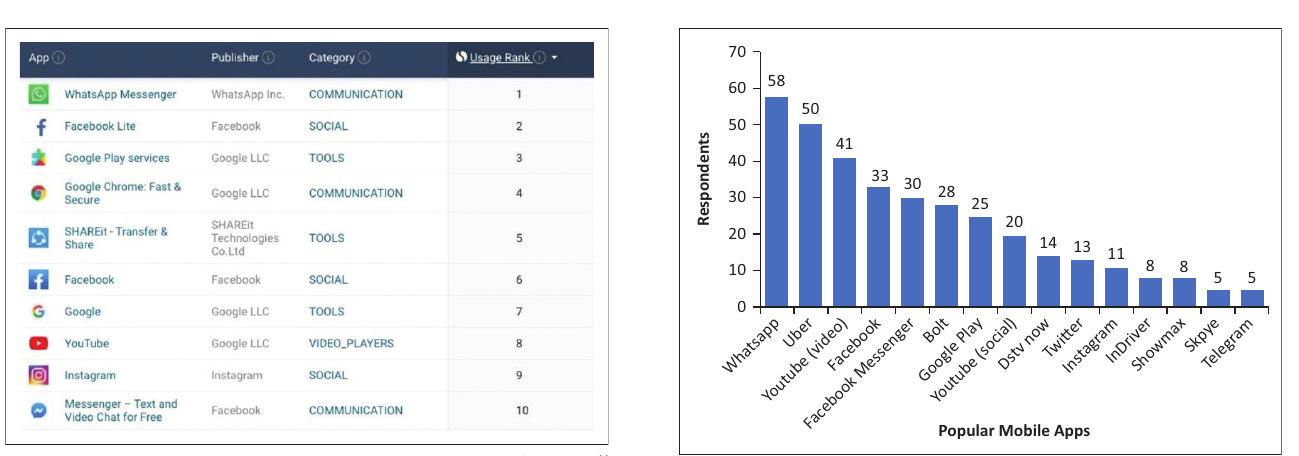
FIGURE 2: Most popular mobile apps used in South Africa, February